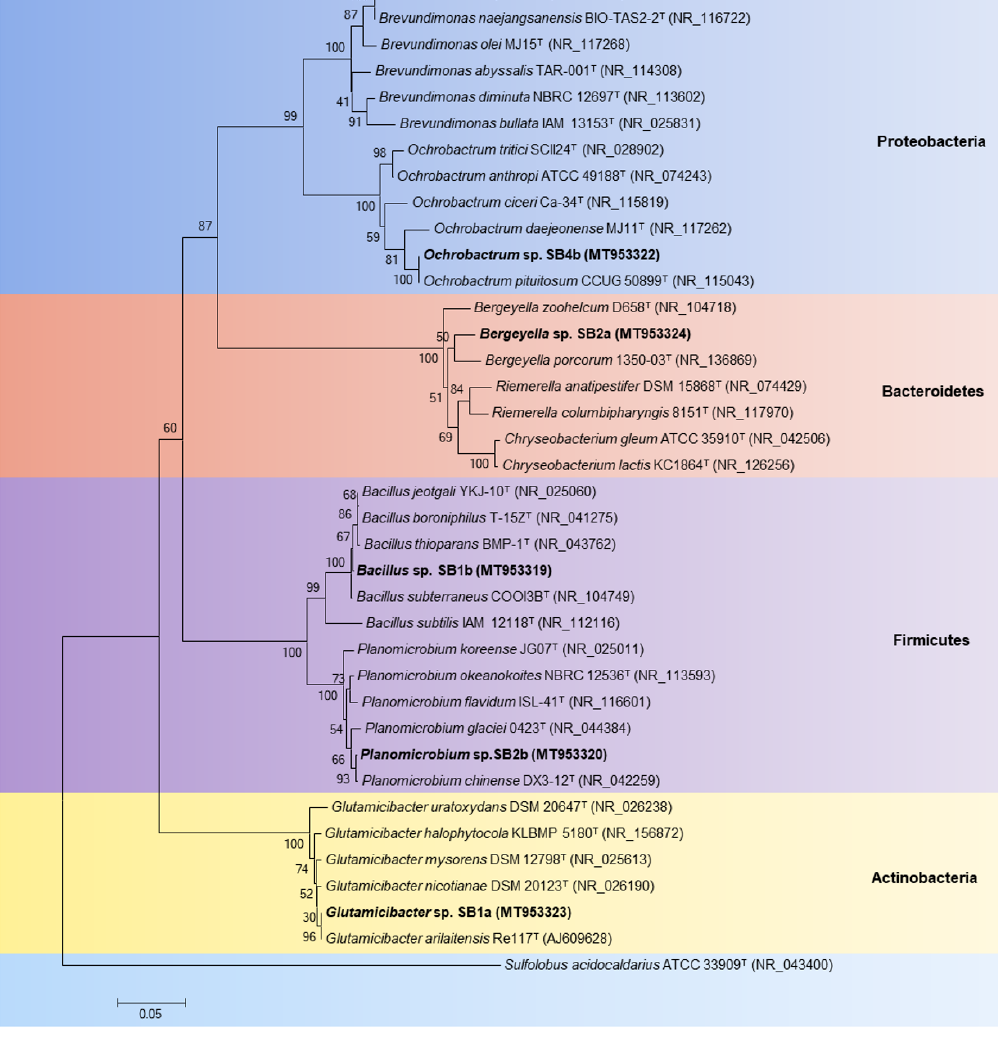
Figure 6. Detection of the merG gene in mercury-tolerant bacterial strains from bioremediated agricultural soil. Lane 1, Molecular mass marker 100 bp plus. Lanes 2–7, Mercury-tolerant bacterial strains SB1a, SB2a, SB1b, SB2b, SB3b, and SB4b. Lane 8, the merG gene positive control ( C. metallidurans strain MSR33 genomic DNA). Lane 9, Negative control.